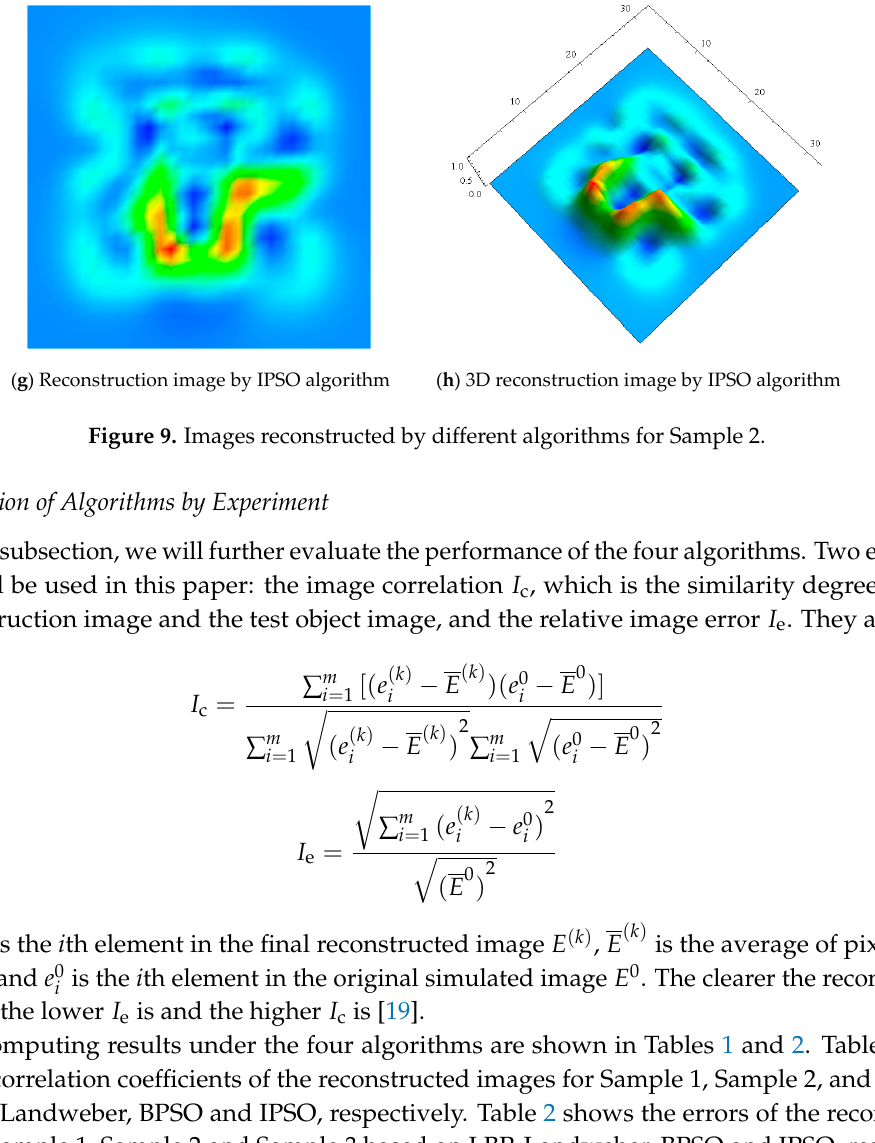
I (%) by different algorithms. Table 1. Image correlation c Table 1. Image correlation I c (%) by different